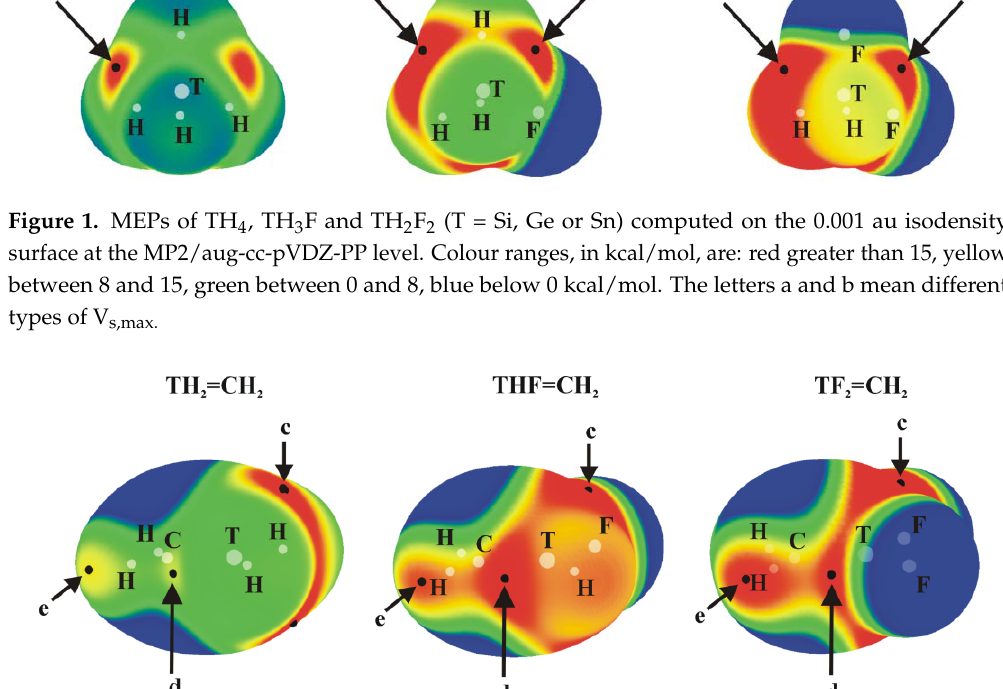
Figure 2. MEPs of TH 2- n F n =CH 2 isolated molecules, computed on the 0.001 au isodensity surface at the MP2/aug-cc-pVDZ-PP level. Colour ranges, in kcal/mol, are: red greater than 15, yellow between 8 and 15, green between 0 and 8, blue below 0 kcal/mol. The letters c, d and e mean different types of V s, max .